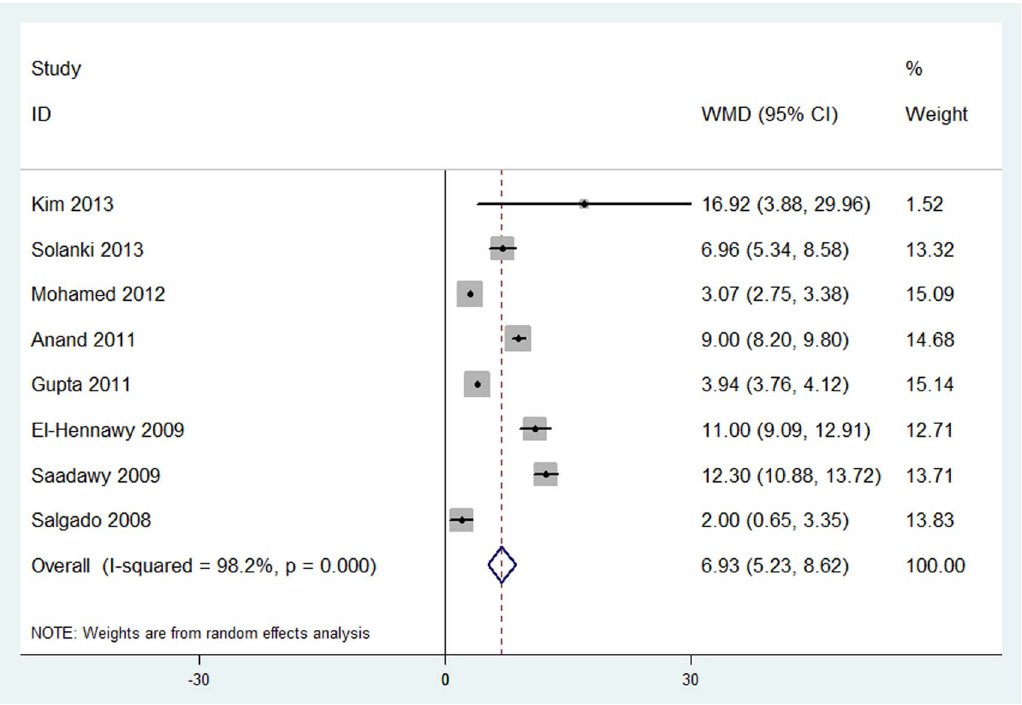
Figure 3. Forest plot: Postoperative analgesic duration.